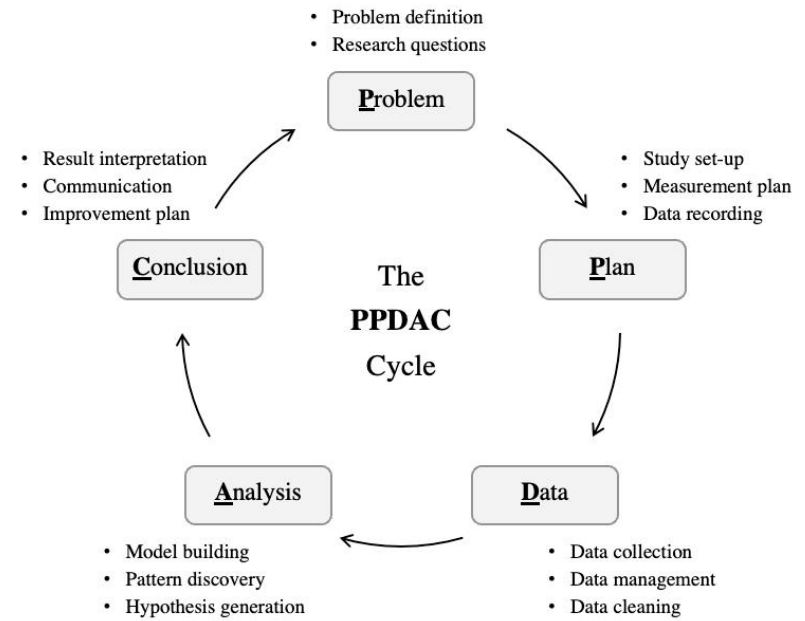
Figure 1. Elements in the PPDAC problem-solving